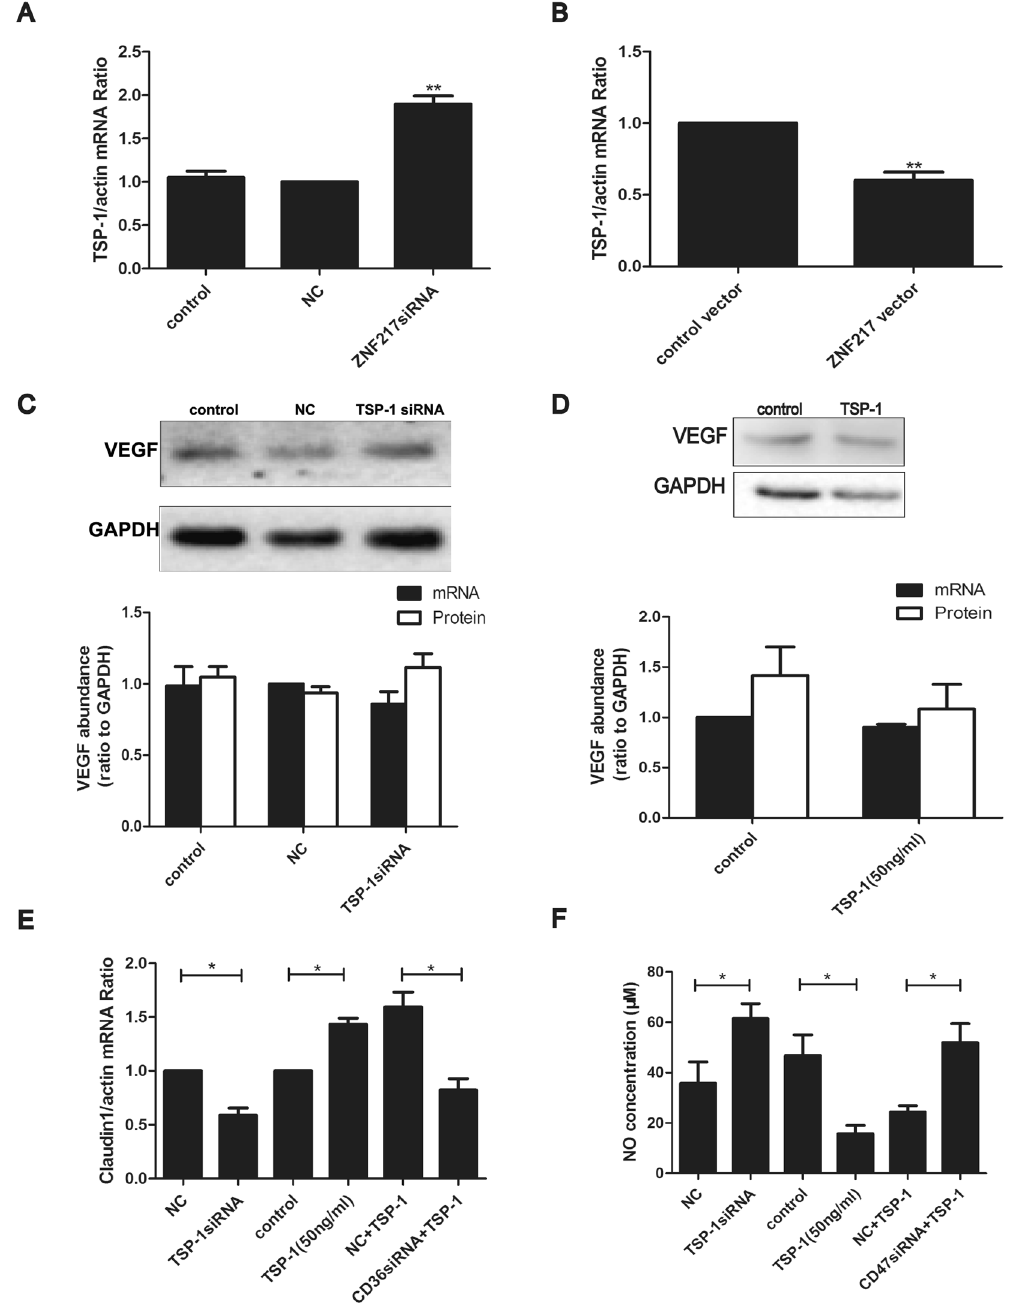
Figure 5. ZNF217 inhibited TSP-1 in KGN cells and then increased VP in HUVECs. ( A ) The expression of TSP-1 mRNA after ZNF217 knock-down in KGN cells. ( B ) The expression of TSP-1 mRNA after ZNF217 over- expression in KGN cells. ( C ) The expression of VEGF mRNA and western blot analysis of VEGF after TSP-1 reduction in HUVECs. ( D ) The expression of VEGF mRNA and western blot analysis of VEGF after TSP-1 protein (50 ng/ml) treatment for 24 h in HUVECs. Immunoblot signals were quantified by densitometry, and normalized with GAPDH. E, The expression of claudin1 mRNA level after TSP-1 reduction, TSP-1 (50 ng/ml) treatment for 24 h and CD36 knock-down in HUVECs. After CD36 siRNA treatment for 48 h, HUVECs were treated with TSP-1 protein (50 ng/ml) for another 24 h. F, NO concentration of cell lysis of HUVECs after TSP- 1 knock-down, TSP-1 protein treatment for 24 h and CD47 reduction. * P < 0.05, ** P < 0.01. n = 3 separate experiments. Data were expressed as mean ± SD. Western blots are the representative